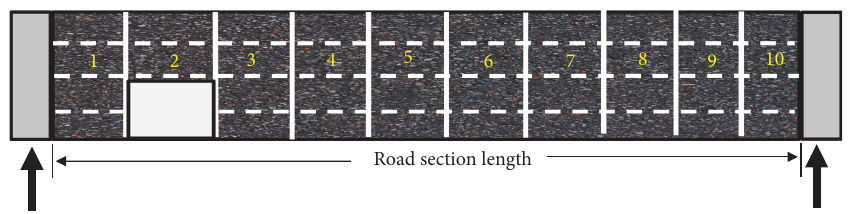
Figure 11: Model setup for simulated reality.